Question: Express in one sentence what the figure is showing.
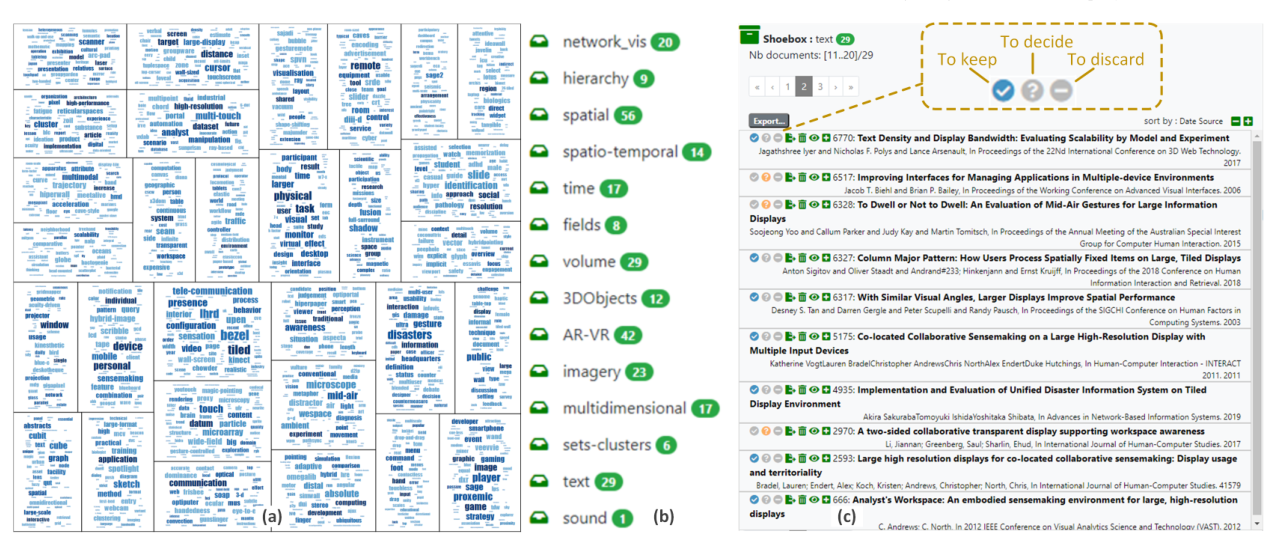
Answer: Papyrus software [MGN16] showing (a) a map of topics extracted from the scientiﬁc corpus of 701 papers, (b) 14 shoeboxes created with the related number of papers, (c) a subset of papers assigned to the shoebox related to textual data with the annotation mechanism.